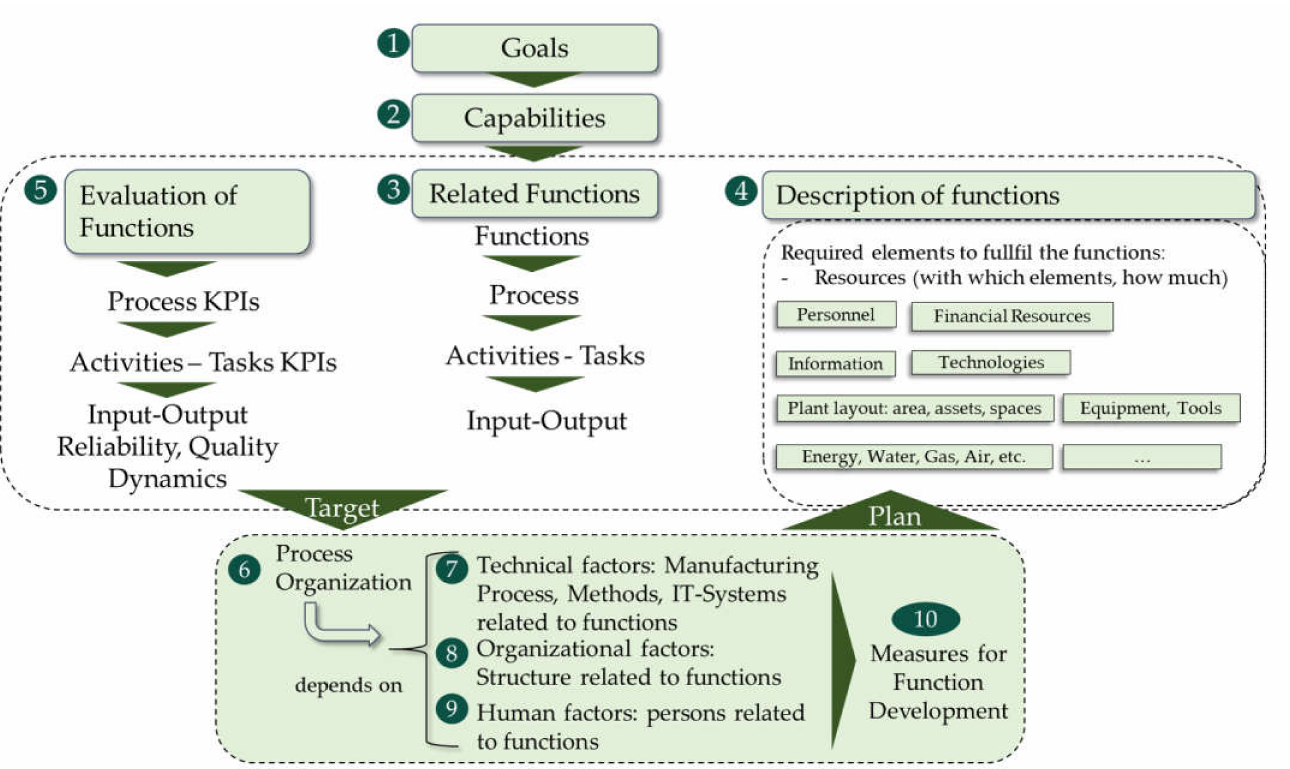
Figure 7. Development of Functions aligned with organizational goals (the authors’ own